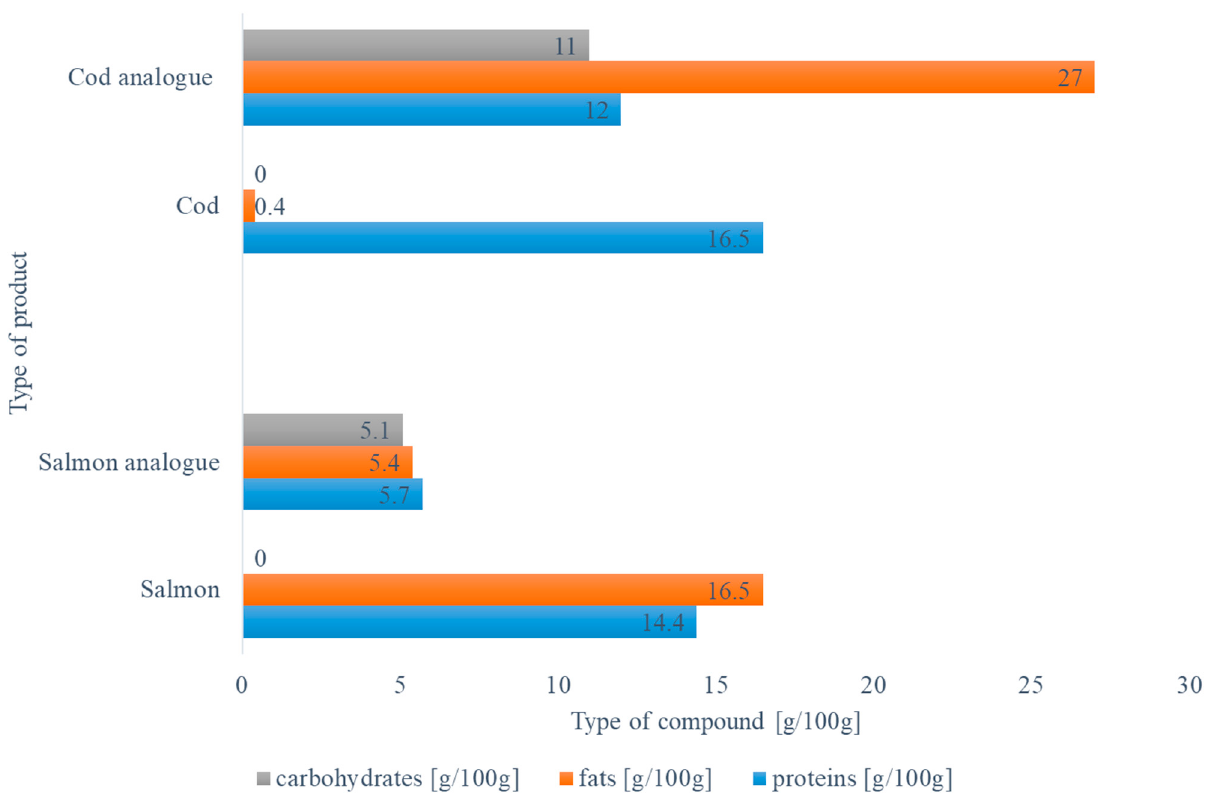
Figure 3. Comparison of fish and fish analogs (salmon and cod nutritional value—[55], salmon analog—Revo, Cod analog—TKC Veg Cod Fillet).